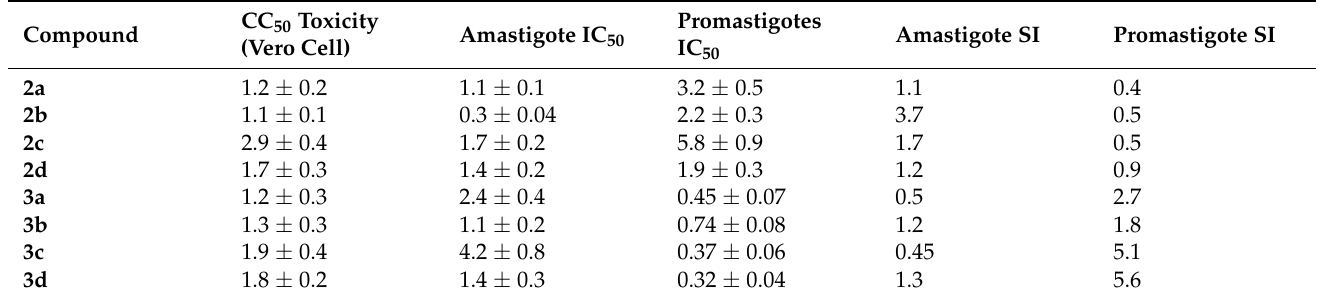
Table 4. Antileishmanial activity of selected compounds against L. major promastigotes and amastig- otes in IC 50 and CC 50 of µ M mL − 1 of mean ± S.D.